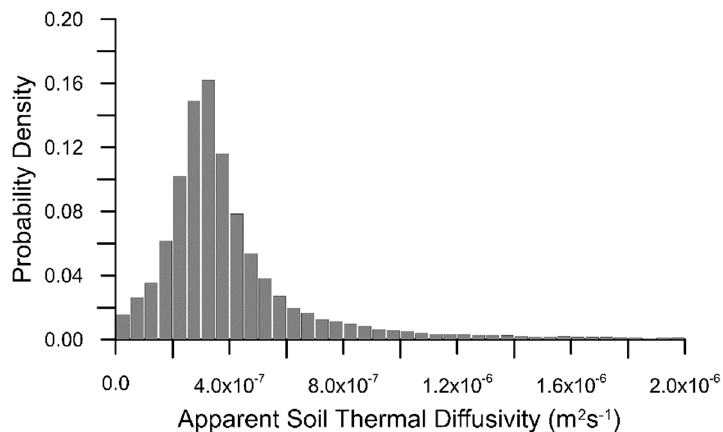
Figure 13. Probability density of Apparent Thermal Soil Diffusivity at TVGr.